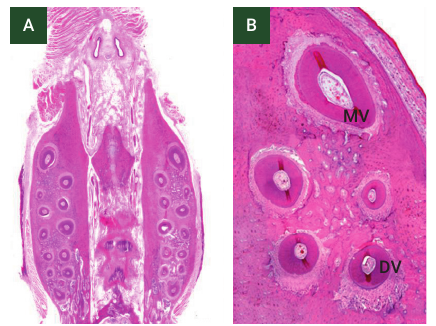
Figure 2. A - Microscopic cross section of the jaw (Staining - HE, magnification-4x). B - Microscopic cross section of the upper first molar, occlusal view. MV - mesiobuccal root. DV - distobuccal root (Staining - HE,